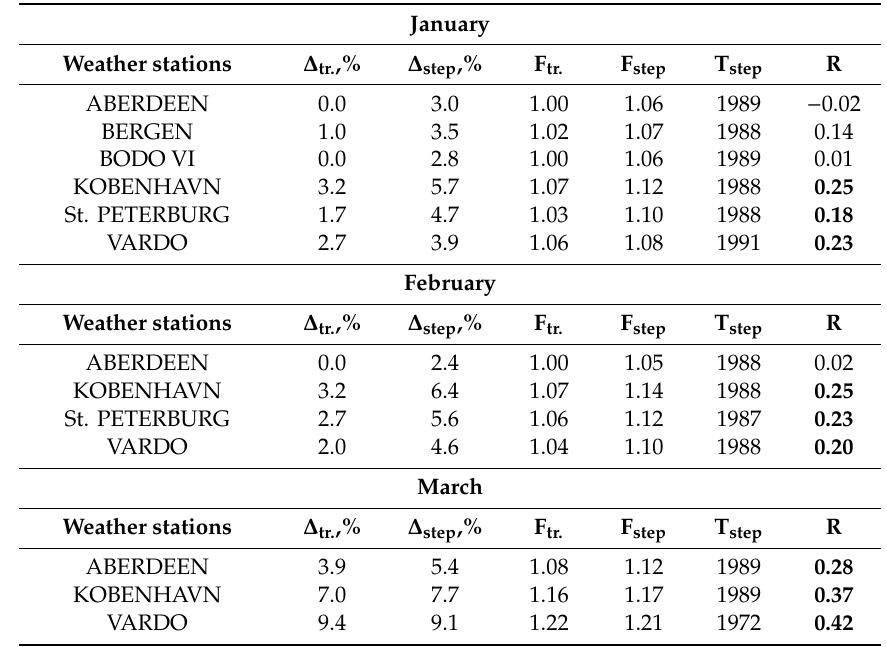
Table 9. The results of the e ffi ciency assessment of non-stationary models for the SAT time series at the weather stations in Northern Europe in January, February and March (1872–2016 period with the size of the time series n = 145). The bold font for R denotes statistically significant correlation coe ffi cients of linear trends for the whole